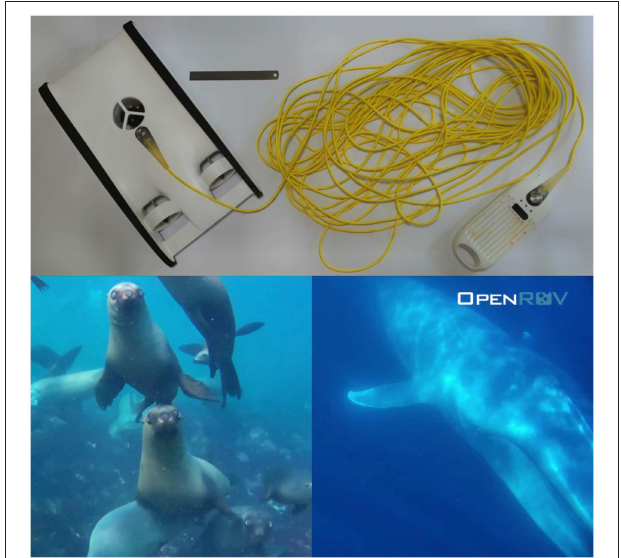
FIGURE 1 | Top: An example of a microROV system (OpenROV Trident) with 20m tether and topside control system. 15cm ruler provided for scale. Bottom left: Sea lions investigate a microROV off the California coast. Bottom right: a blue whale approaches and swims past a stationary microROV during a commercial whale watching excursion near Moss Landing, California. All photos used with